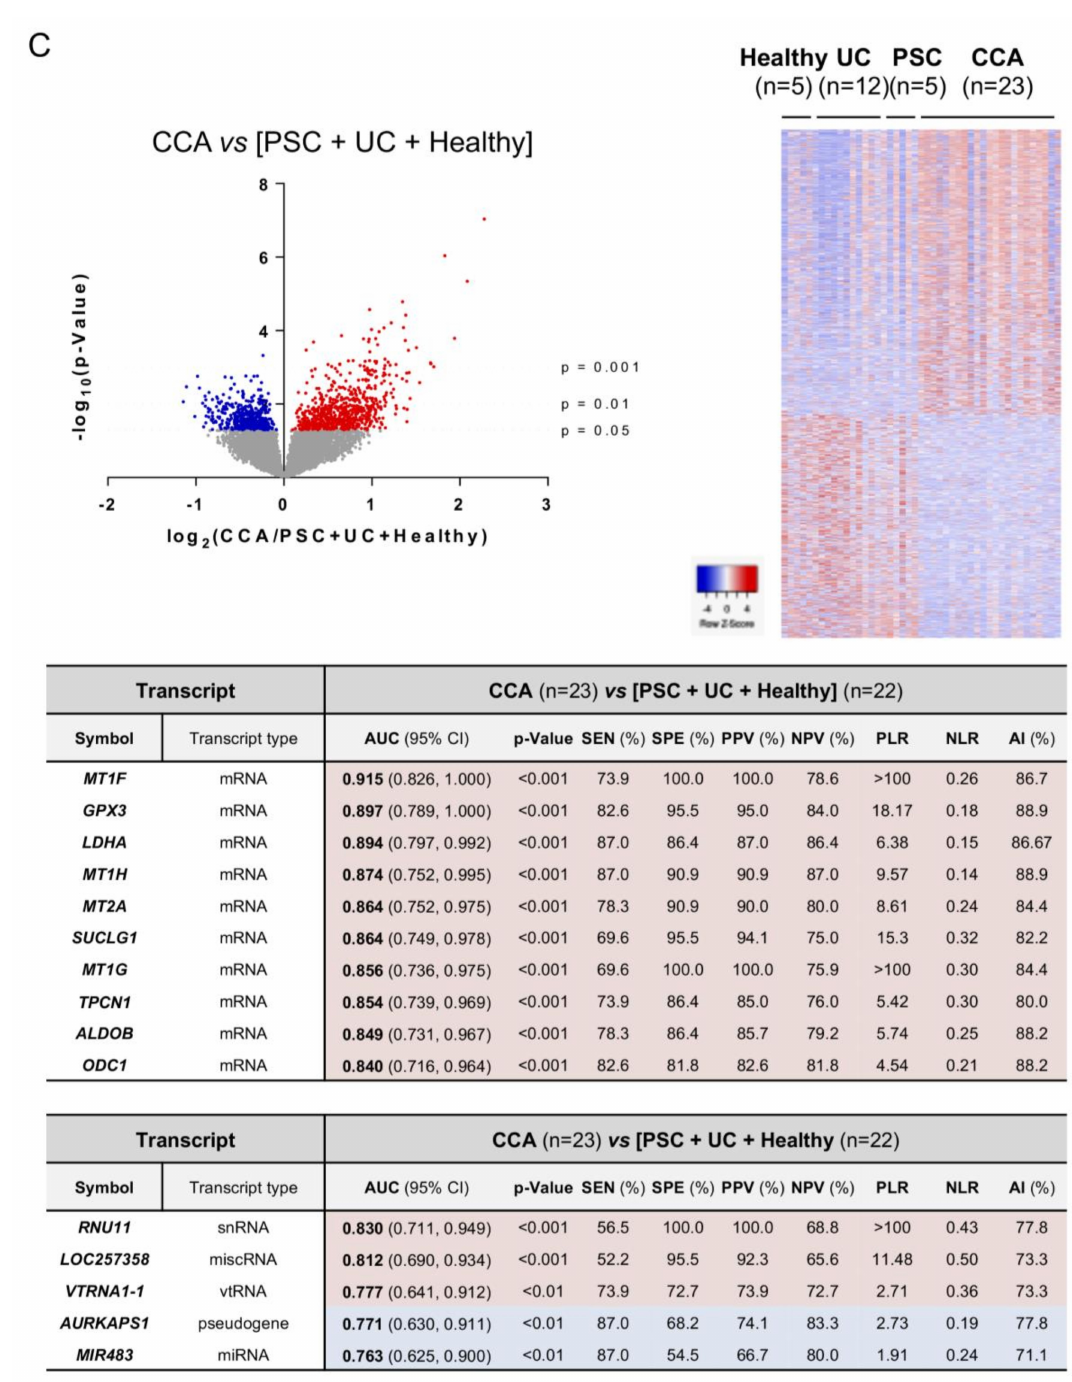
Figure 7. Di ff erential transcriptomic profile of urine EVs and diagnostic capacity. Volcano plot ( − log 10 ( p -value) and log 2 (fold-change); up left), heatmap of the di ff erentially expressed transcripts (up right) and diagrams with the diagnostic capacity with the highest AUC values of the 10 selected mRNAs and 5 selected non-coding RNAs in serum EVs from ( A ) CCA vs. Healthy individuals; ( B ) CCA vs. PSC; ( C ) CCA vs. (PSC + UC + Healthy individuals). Abbreviations: AI, accuracy index; AUC, area under the receiver operating characteristic curve; CI, confidence interval; miRNA, microRNA; lncRNA, long non-coding RNA; miscRNA, miscellaneous RNA; NLR, negative likelihood ratio; NPV, negative predictive value; PLR, positive likelihood ratio; PPV, positive predictive value; SEN, sensitivity; snRNA, small nuclear RNA; snoRNA, small nucleolar RNA; SPE, specificity; vtRNA, vault